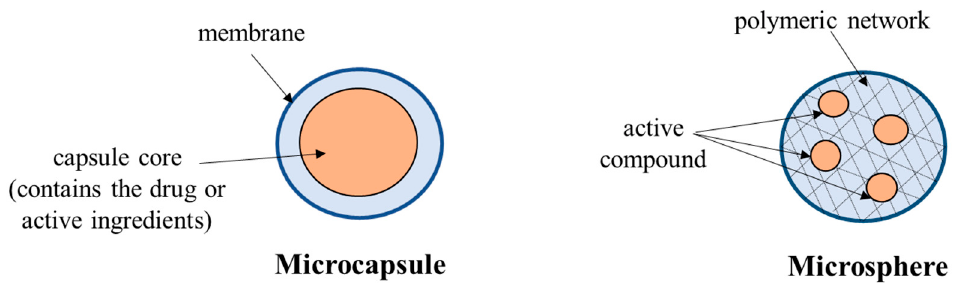
Figure 4. Graphical representation of drug encapsulation (adapted from Madene et al. [74] with permission from the publisher).